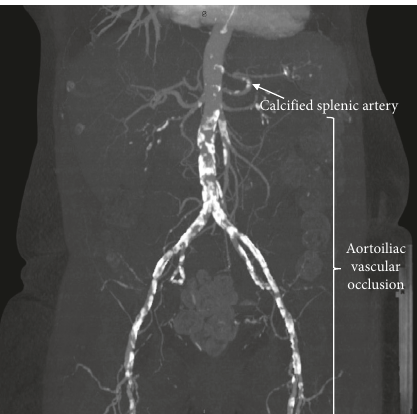
Figure 5: A CTreconstruction showing aortoiliac vascular occlusion and calcified splenic artery. This is a complex case that could require the anastomoses to the native renal vessels.